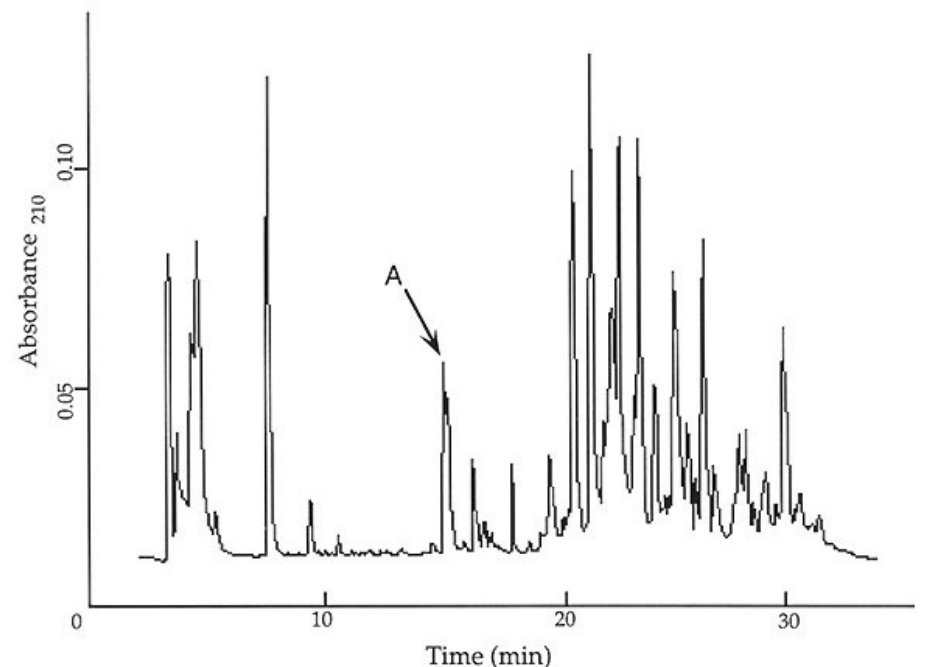
Figure 2: HPLC chromatogram of H. formidabilis crude venom. The HPLC gradient was as described in Materials and Methods. The peak marked A corresponded to insecticidal material. This fraction was subjected to secondary fractionation by HPLC.